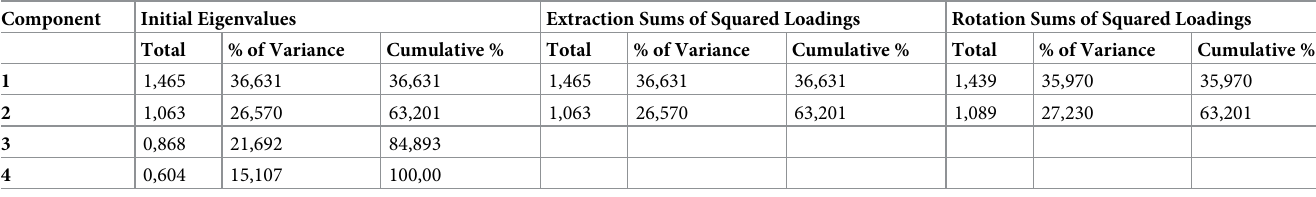
Table 5. Total variance explained (students participating in the